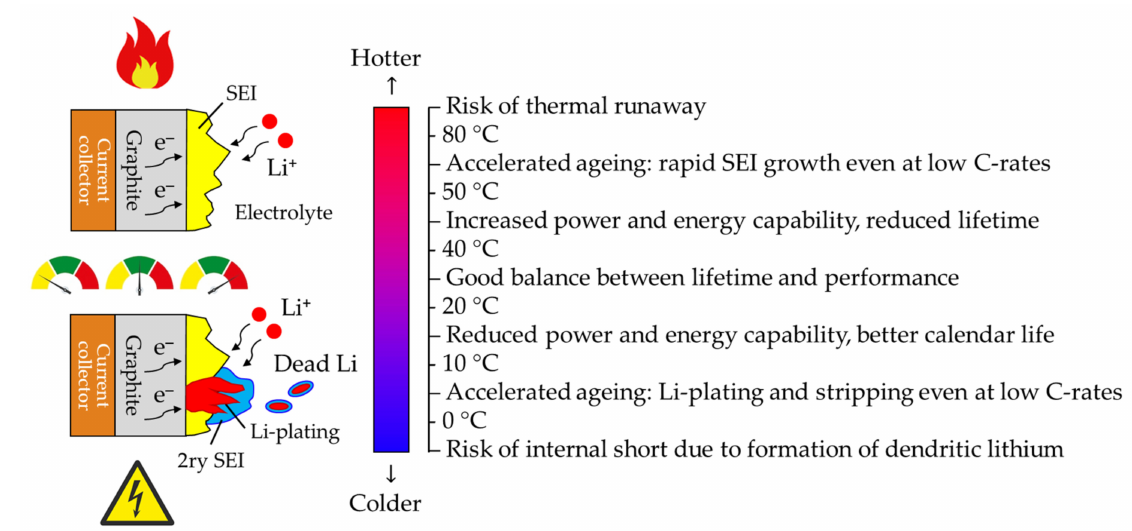
Figure 1. Overview of major thermal issues in lithium-ion